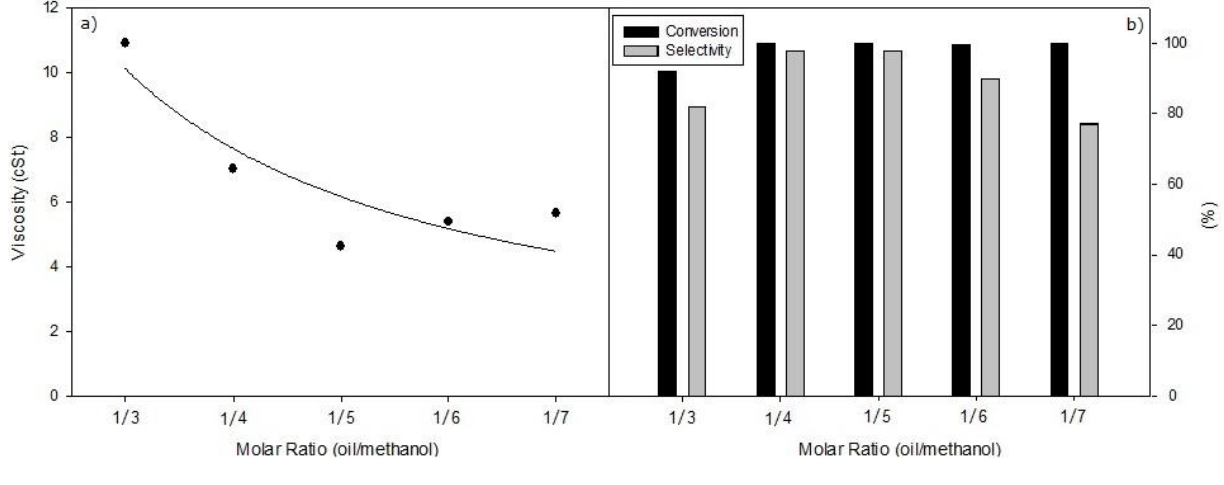
Figure 3. ( a ) Viscosity values and ( b ) Conversion and Selectivity values, obtained in the heterogeneous selective methanolysis of sunflower oil under standard conditions, with different molar oil/methanol ratios, reaction time 60 min, reaction temperature 65 °C, 12 mL oil and 0.8 g of KF/Al O 2 3